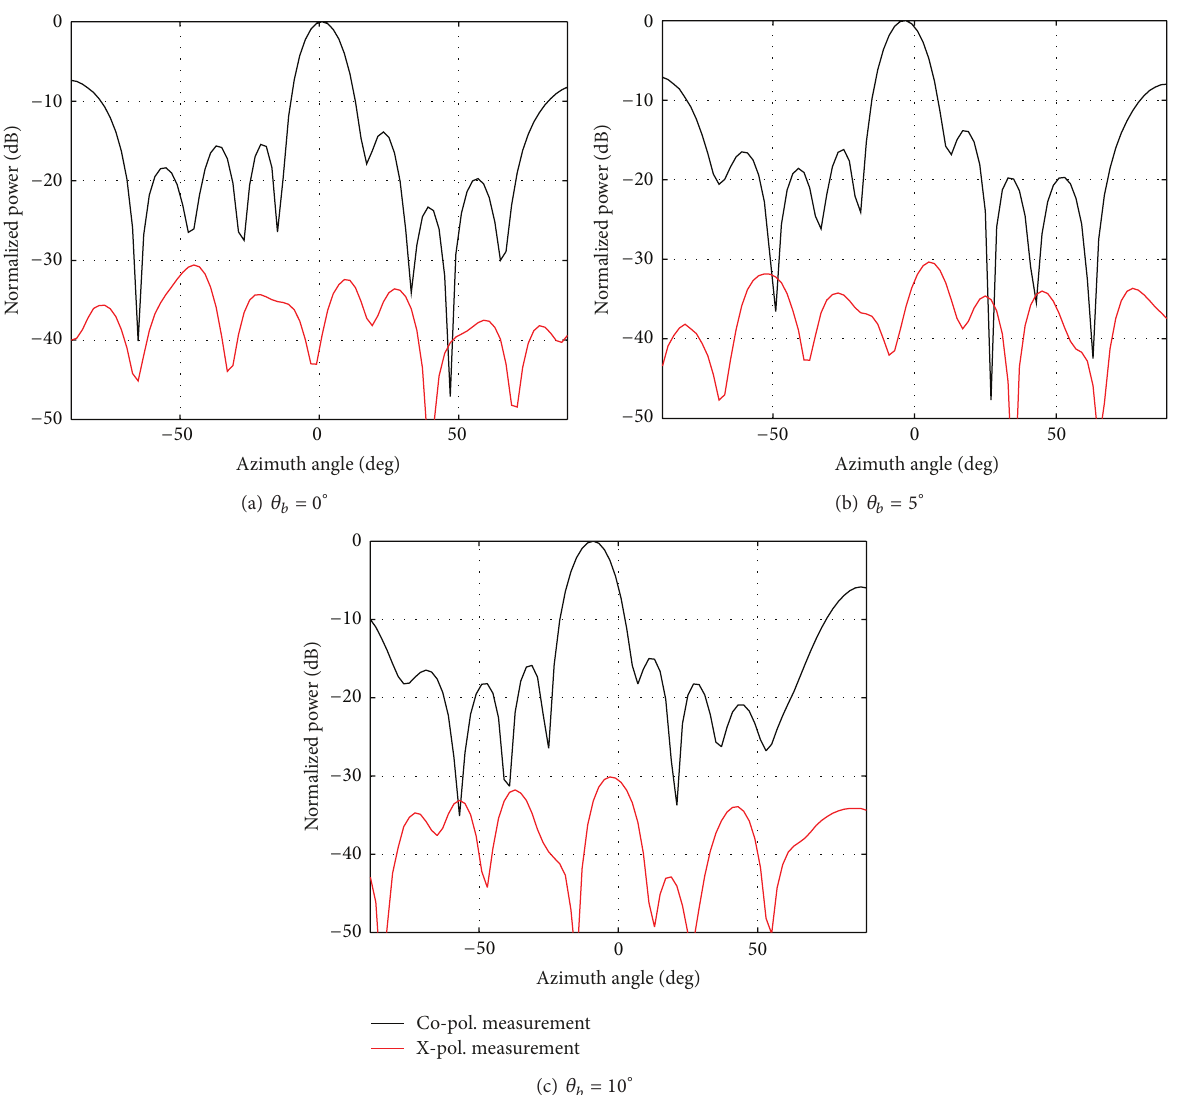
Figure 18: Measured 8-element circular array patterns. Beam-steering angle 𝜃 𝑏 is in azimuth